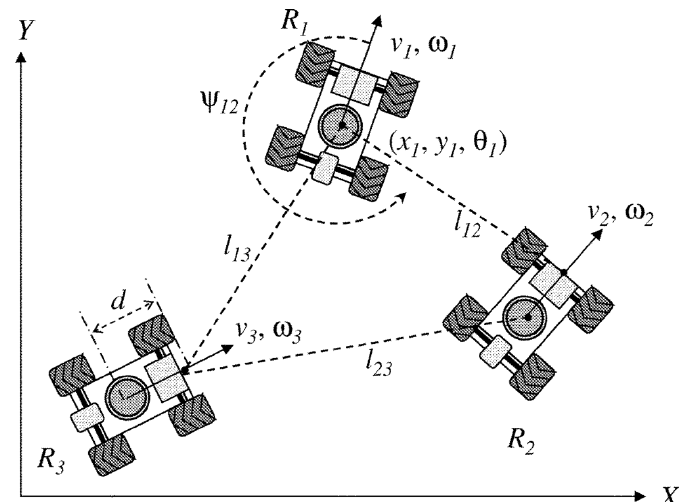
Figure 6. Three robots using basic leader-following controller (Source: [41]).